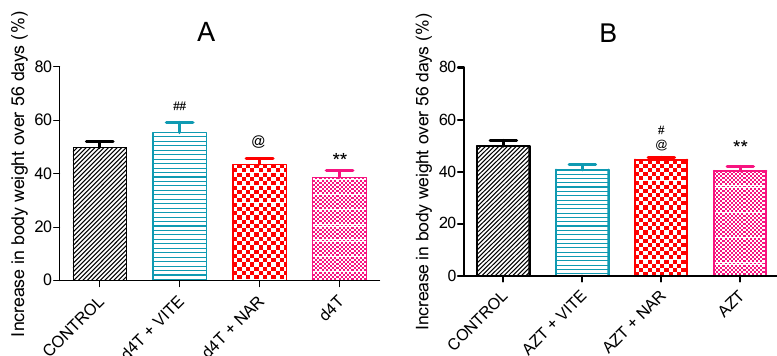
Figure 1. Percentage change in body weight between treatment groups after 56 days of NRTI administration. ( A ) d4T ‐ treated (** p < 0.01 compared to control; ## p < 0.01 compared to d4T) and ( B ) AZT ‐ treated (** p < 0.01 compared to controls; # p < 0.05 compared to AZT) rats. @ p < 0.05 compared to vitamin E among both d4T and AZT ‐ treated rats.